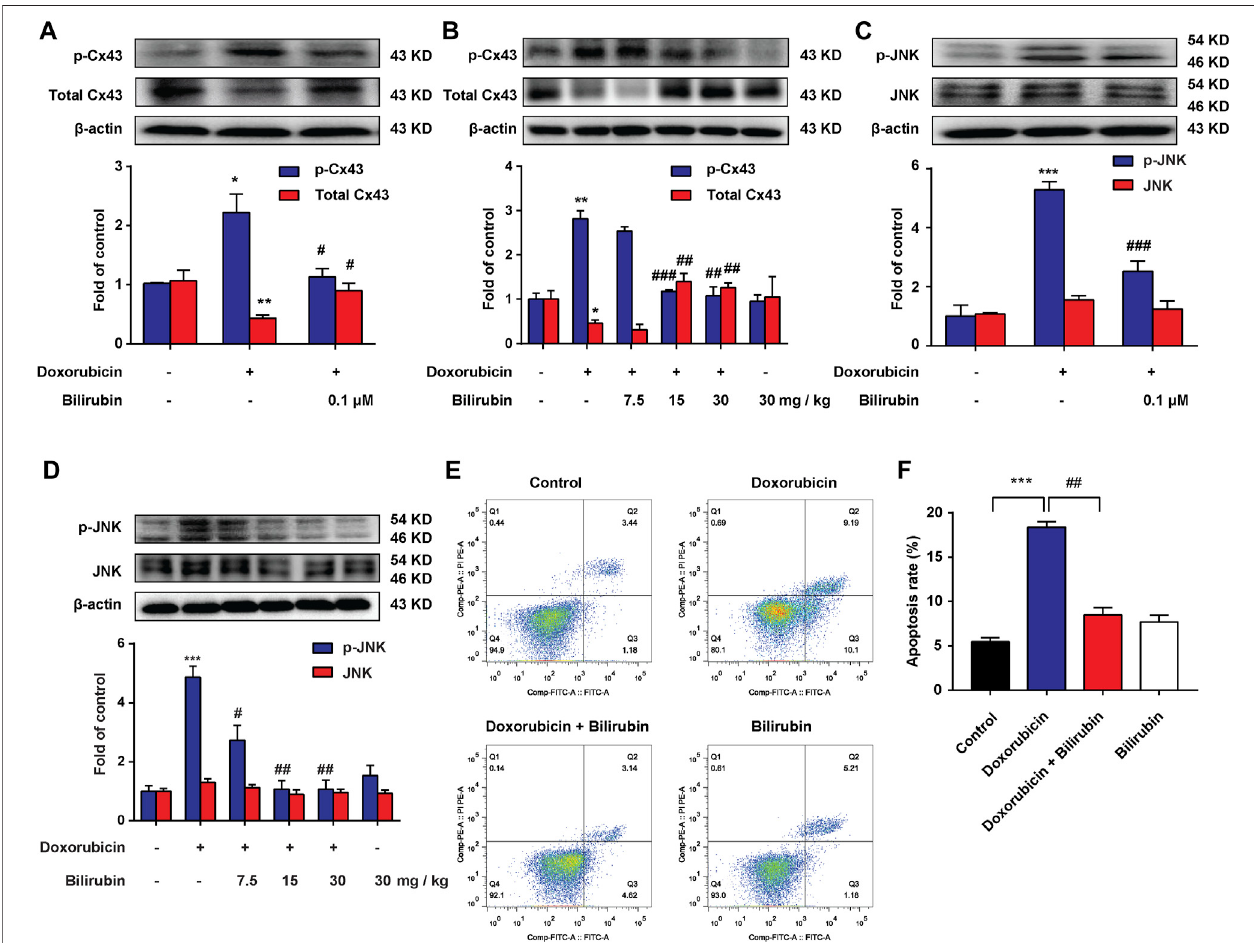
FIGURE 3 | Bilirubin reduces doxorubicin-induced JNK-Cx43 gap junctions ’ dysfunction. (A,C) Representative Western blot images showed the levels of p-Cx43, total Cx43, p-JNK and JNK in H9C2 cells in vitro . (B,D) Representative Western blot images showed the levels of p-Cx43, total Cx43, p-JNK and JNK in heart tissues from doxorubicin-mice given different dose of bilirubin (7.5, 15, and 30 mg/kg, i.p.) for 7 days. The western blot samples were collected and analyzed ( n = 4 of each group). (E) Apoptosis was assessed by fl ow cytometric analysis in H9C2 cells. (F) Quantitative data of the apoptosis ratio analyzed by fl ow cytometry. H9C2 cells were treated with bilirubin (0.1 μ M) for 6 h before doxorubicin (1 μ M) treatment, and the samples were collected 24 h after doxorubicin treatment ( n = 4 of each group). Signi fi cantdifferencewasrevealedfollowingone-wayANOVA (* p < 0.05, ** p < 0.01, *** p < 0.001vs. Controlgroup; # p < 0.05, ## p < 0.01, ### p < 0.001vs.Doxorubicin- treated group; Bonferroni post hoc